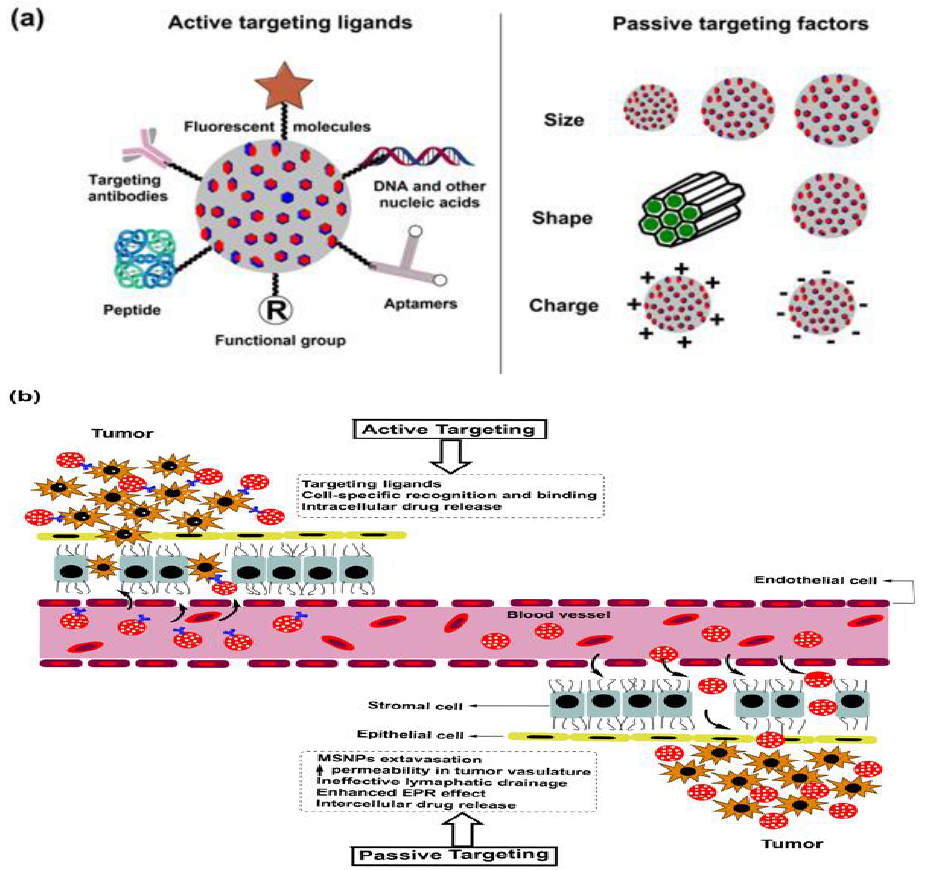
Figure 9. ( a ) Pictorial distinctions of active and passive drug delivery mechanisms in nanoparticles, with the former working through ligand specificity, while the latter relies more on physicochemical properties, such as surface charge, size and morphology. ( b ) Working mechanisms of active and passive drug delivery with the latter being aimed at gathering adequate drug amounts in the tumor cell vicinity, which are subsequently internalized within the cancer cells via physicochemical drift- ing. These distinctions provide the MSNP-mediated drug delivery with the possibility of multiple stimulus-driven performance modulations. Although these controls are empiri- cally the eventualities of the functionalization modes, the explicit terminological distinc- tions for MSNPs are quite significant for understanding them thoroughly with regard to their drug delivery potential. This is often discussed via the shape – size-modulated phys- ical response, assuming a decisive role in tumor cell internalization and sustained drug release, capping agent binding and ligand targeting. The following paragraphs are, thereby, devoted to the prominent and exclusive traits of MSNPs for their drug delivery ability. 4.1. Stimulus Response Delivering drugs using MSNPs is optimally distinguished via modulation using stimulus-responsive conditioning. According to our literature search, the typical configu- ration of such a carrier system comprises active and passive targeting with a gate-trig- gered drug cargo entrapment. Both active and passive targeting exhibit trivial uncertainty, characterized by a premature cargo release during circulation, easily resolved via gate- stimulus-driven drug penetration in the MSNPs. On reaching the target sites, this gate opens in response to variations in pH, temperature, enzymes and redox status, among other things (Figure 10). Based on the number of stimuli, these mechanisms are distin- guished as single, dual or multiple. The administered stimulus could be in situ or exter- nally optimized, as summarized in Figure 11. Noted external stimuli are thermal energy via temperature enhancement, irradiation via visible and higher energy waves or ultra- sound-assisted drug carrier detachment.